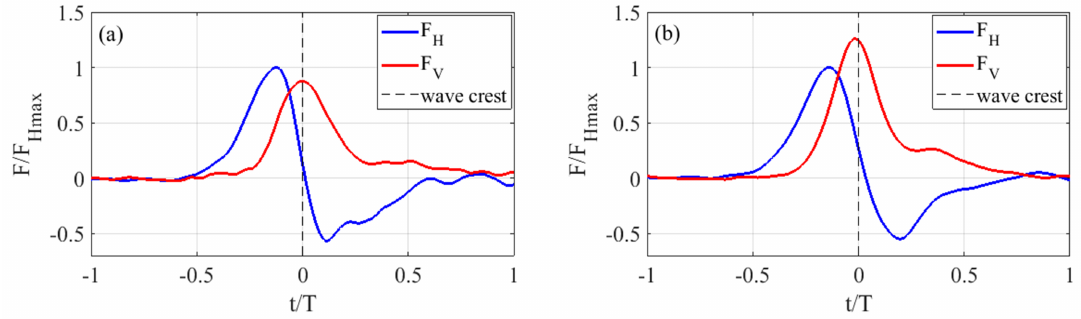
Figure 5. Time variation of experimental horizontal ( F H ) and vertical ( F V ) hydrodynamic forces. ( a ) Test number 5; ( b ) Test number